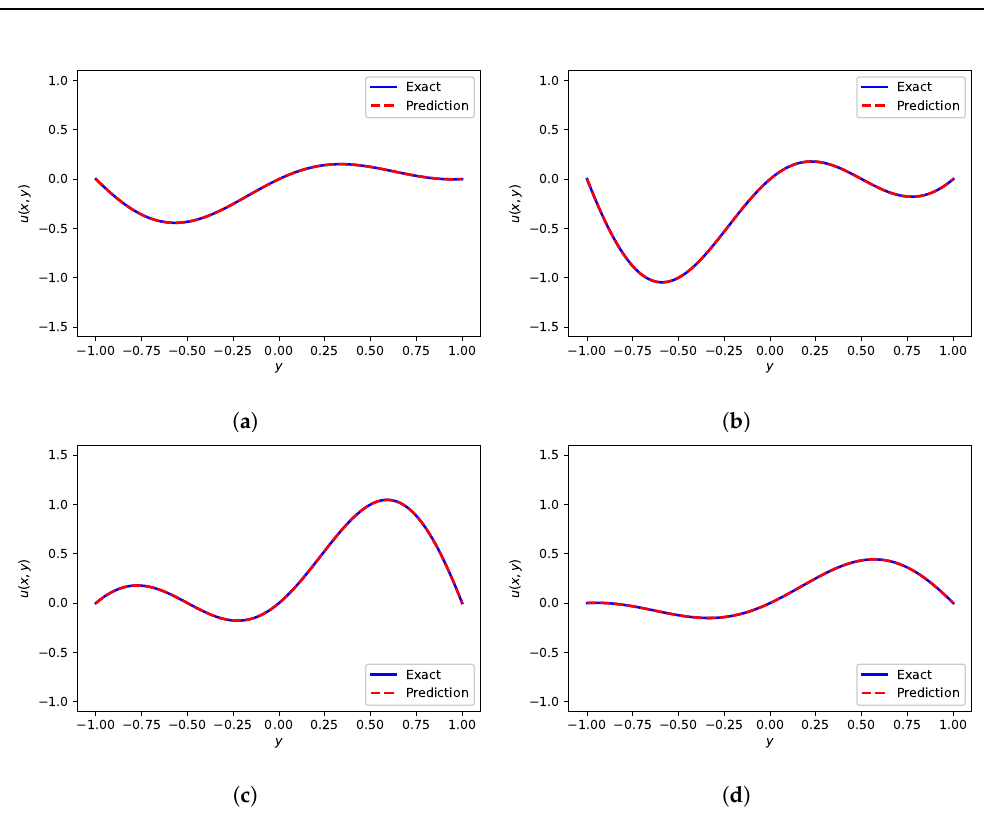
Figure 19. Comparison of predicted solution and exact solution of Equation (64) at different x . ( a ) x = − 0.9; ( b ) x = − 0.5; ( c ) x = 0.5; ( d ) x =